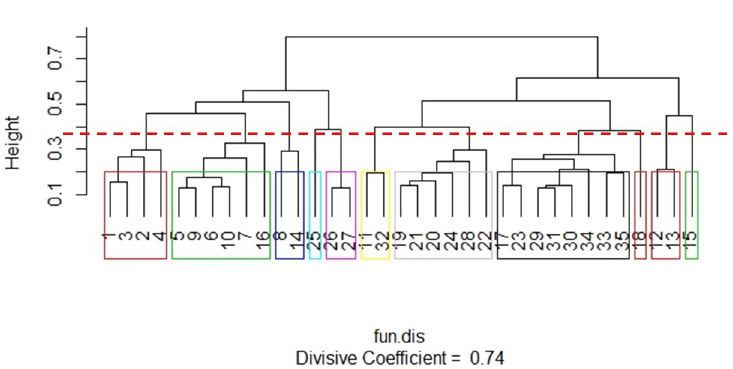
Fig 2. Dendrogram showing the 11 functional groups produced from the Gower index with divisive hierarchical clustering technique with the functional attributes of 35 species of scarab beetles. Functional groups were considered at an arbitrary Gower distance (dotted